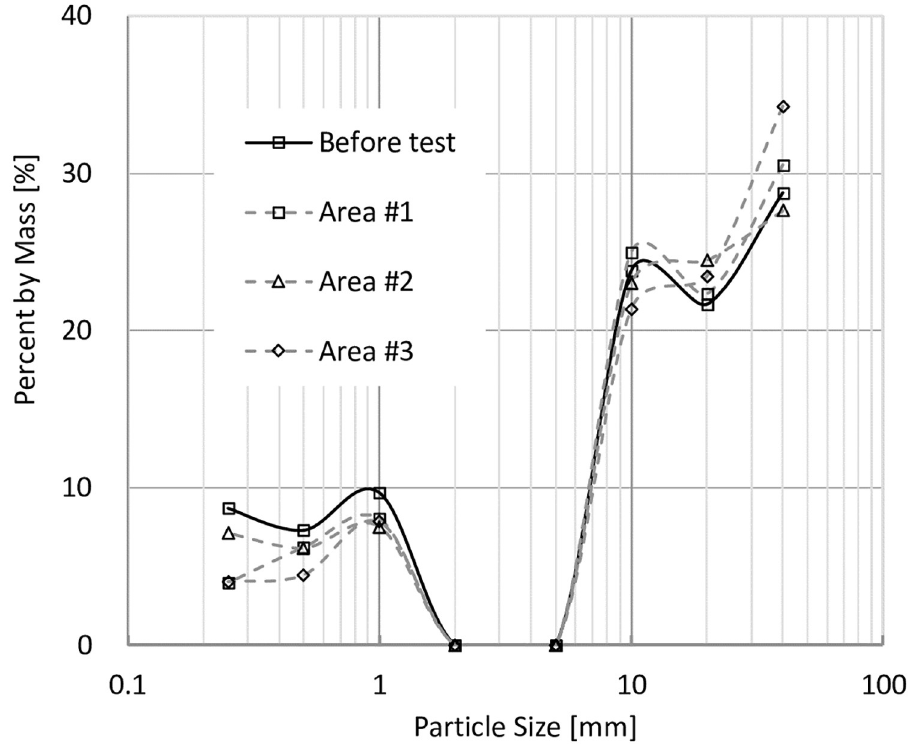
Fig 16. Frequency of particles with different sizes in each area of the model with VFR =